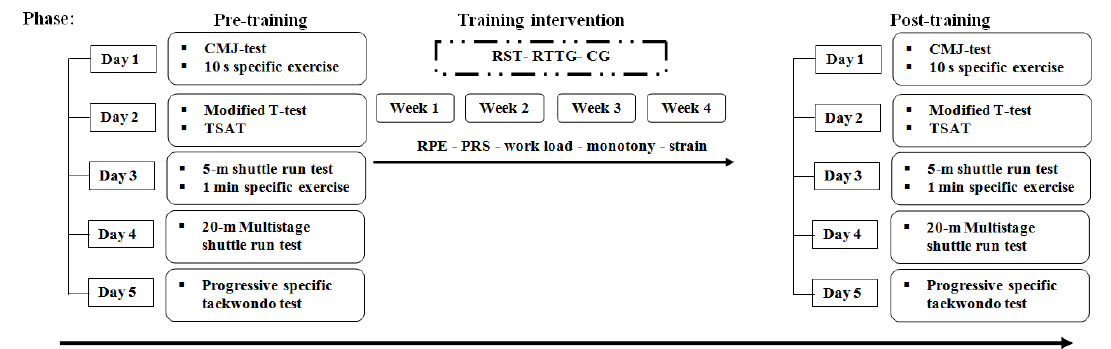
Figure 1. Schematic representation of the study design. CMJ: countermovement jump; TSAT: taekwondo specific agility test; RST: repeated sprint training group; RTTG: repeated technique training group; CG: control group; RPE: rating of perceived exertion; PRS: perceived recovery.